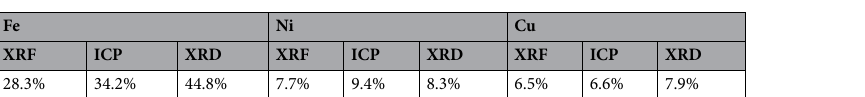
Mineral Pentlandite Magnetite Chalcopyrite Pyrrhotite Lizardite Pyrite Quartz Errors% 1.7 Table 2. XRD quantitative phase analysis of the Ni–Cu sulphide ore sample.